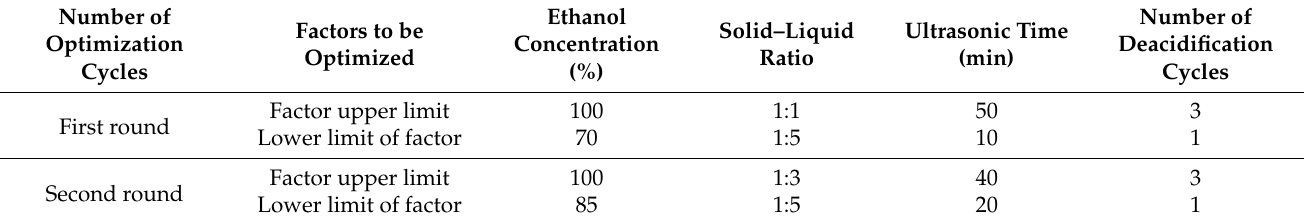
Table 9. The four variables and the ranges of their values were inputted to the RCO pro- gram (RCOPTNS), and 13 sets of proposed paramter values were yielded from the random search. These sets of parameters were then applied to the treatment of SSO samples in the UAEE process. Table 9. Range of parameters to be